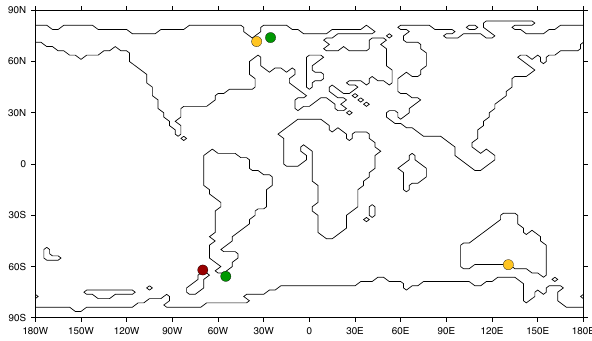
5 Fig. 3. Locations of some of the fossil evidence from the early Fractional Coverage Eocene. The red circle represents the location of fossil wood, yel- low represents pollen and green represents fossil leaves. Data from Contreras et al. (2013), Francis and Poole (2002), Harrington et al. (2012), Cantrill et al. (2011) and Eberle and Greenwood